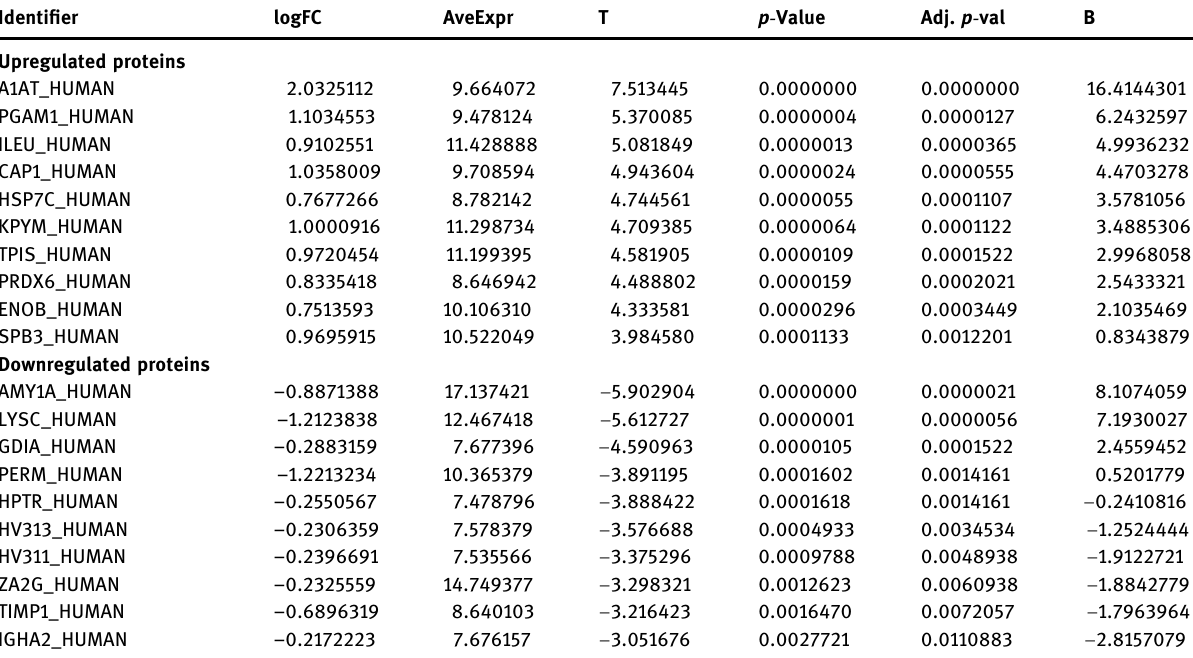
Table 2: Top ten proteins with signi fi cantly altered expression in saliva of TMD patients compared to healthy controls according to p - values Identi fi